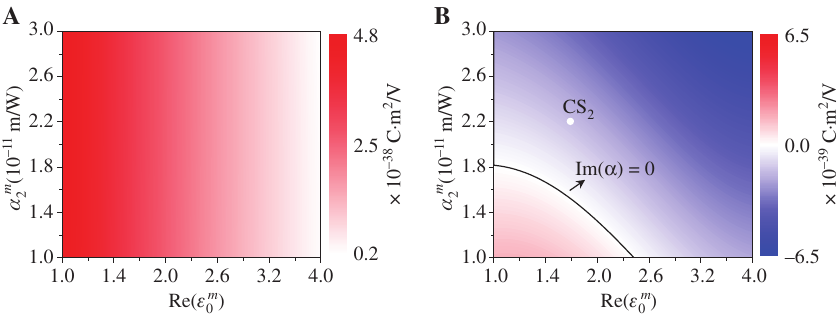
m α of the solvent. The black 2